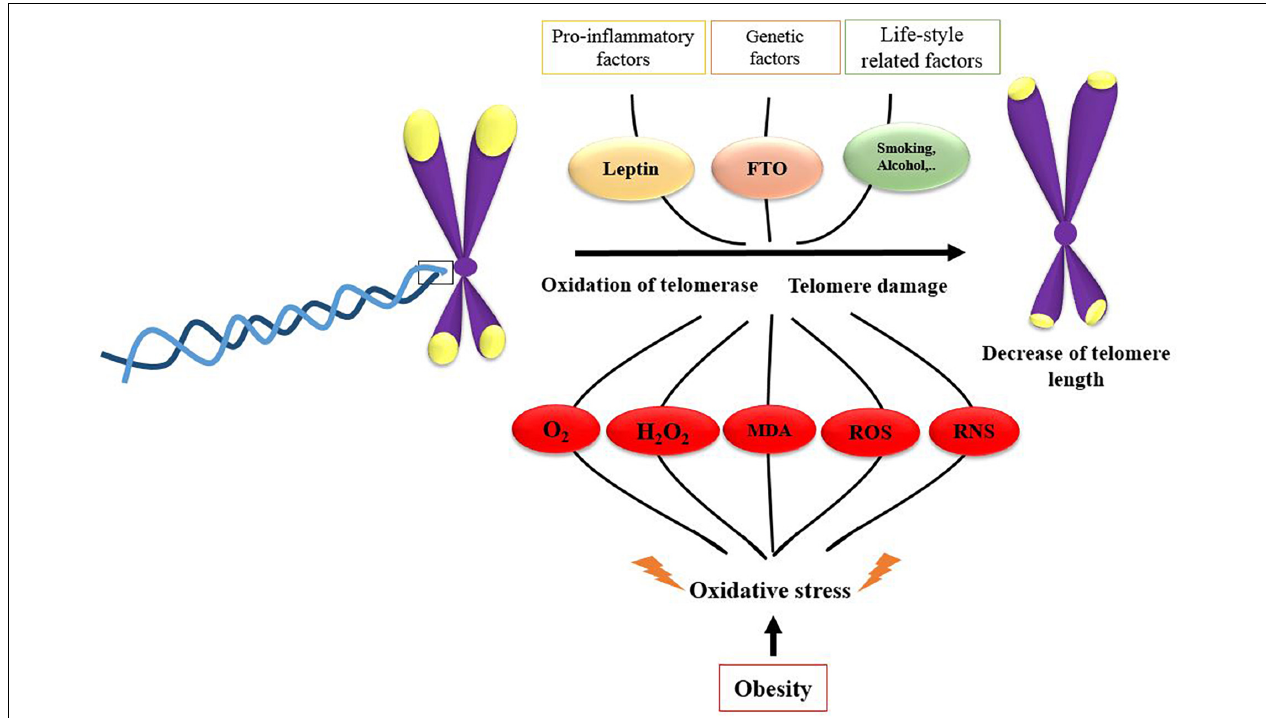
FIGURE 4 | Mechanistic pathways of the possible role of obesity and obesity-related risk factors on leukocyte telomere length